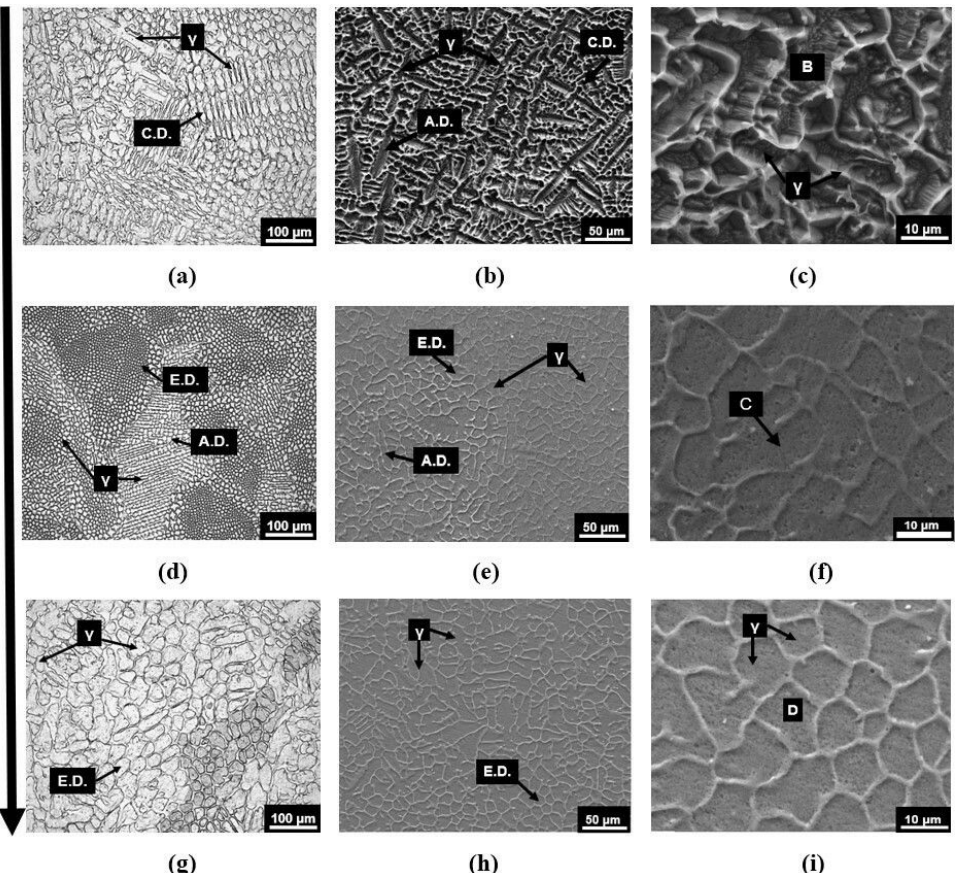
Figure 4. OM and SEM-adjusted micrographs of the 316L stainless steel, rapid solidification processing route. (a-c) Region RS1; (d-f) Region RS2; (g-i) Region RS3. A.D.= Acicular dendritic. C.D.= Columnar dendritic. E.D.= Equiaxial dendritic. γ= austenite phase. B/C/ D= region of EDS analysis.